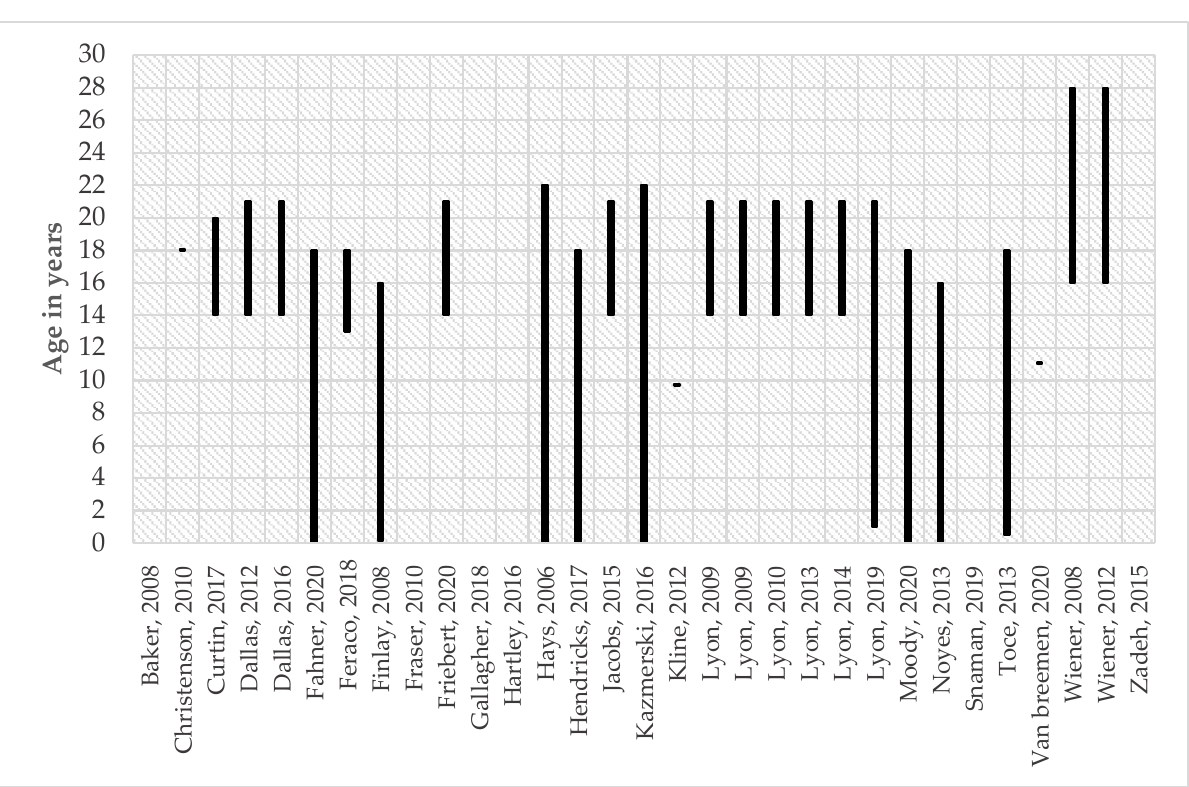
Figure 2. Age range in study population per article [11,31–60]. Table 7. Intervention characteristics.